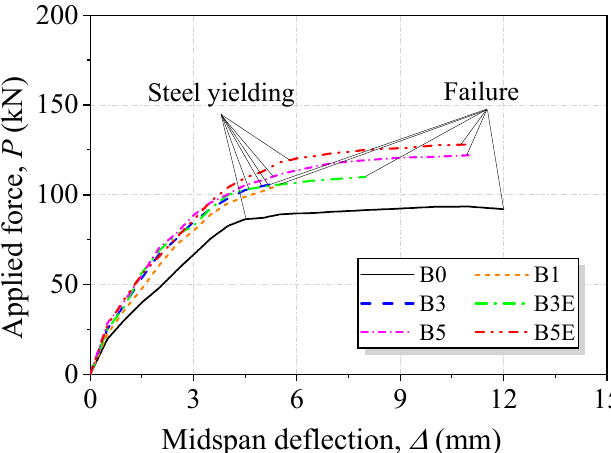
Figure 9. Applied force versus midspan deflection curves for tested beams. The maximum applied force, defined as the failure force ( P u ) , was measured during bending tests and is presented in Table 1. B0 showed a P u value of 93.5 kN. For the strengthened beams, P u ranged between 105.5 kN for B1 and 128.1 kN for B5E. The increases were 13% and 37% for B1 and B5E, respectively, compared to B0. In addition, the difference in P u between B3 and B3E was 4%, and this difference was 6% between B5 and B5E. Although end anchorage had a beneficial effect on the deflection and failure mode, slight differences in P u appeared for the strengthened beams with and without end anchorage. In addition, P u increased with an increase in the reinforcement amount of the textile, and a linear dependence was found between P u and the textile reinforcement amount, as shown in Figure 10.